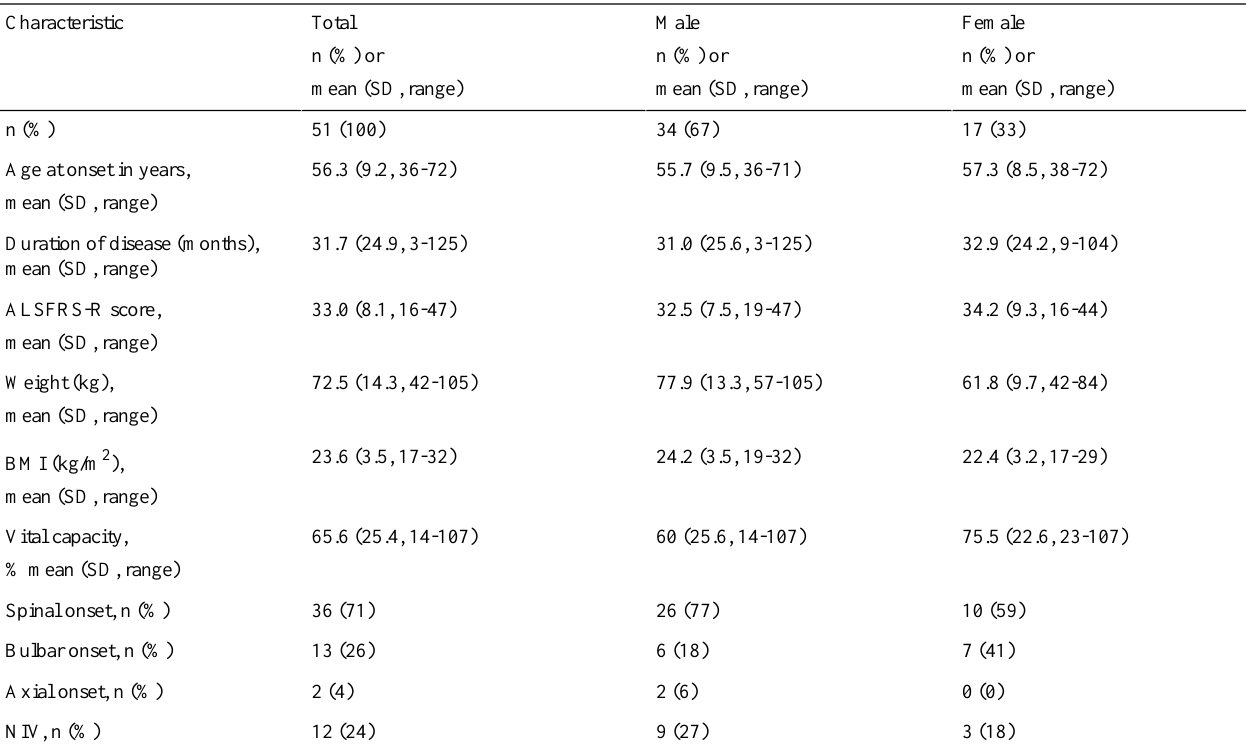
During the study period of 6 months, 8 patients underwent PEG. 9 patients died within the observation period. The majority of Table 1. Descriptive characteristics of the study population during baseline visit. Numbers show mean, SD, and